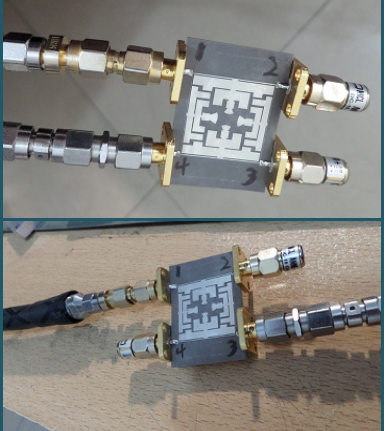
Figure 18. Photos of the fabricated BLC under test.